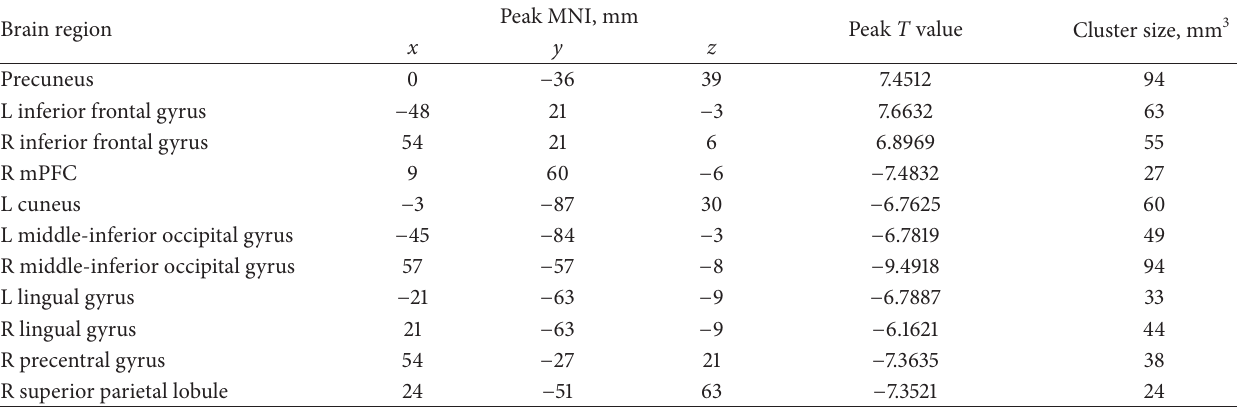
Table 2: Regions showing significant ALFF differences between PT patients and controls ( 𝑃 < 0.01 corrected for multiple comparisons using Monte Carlo